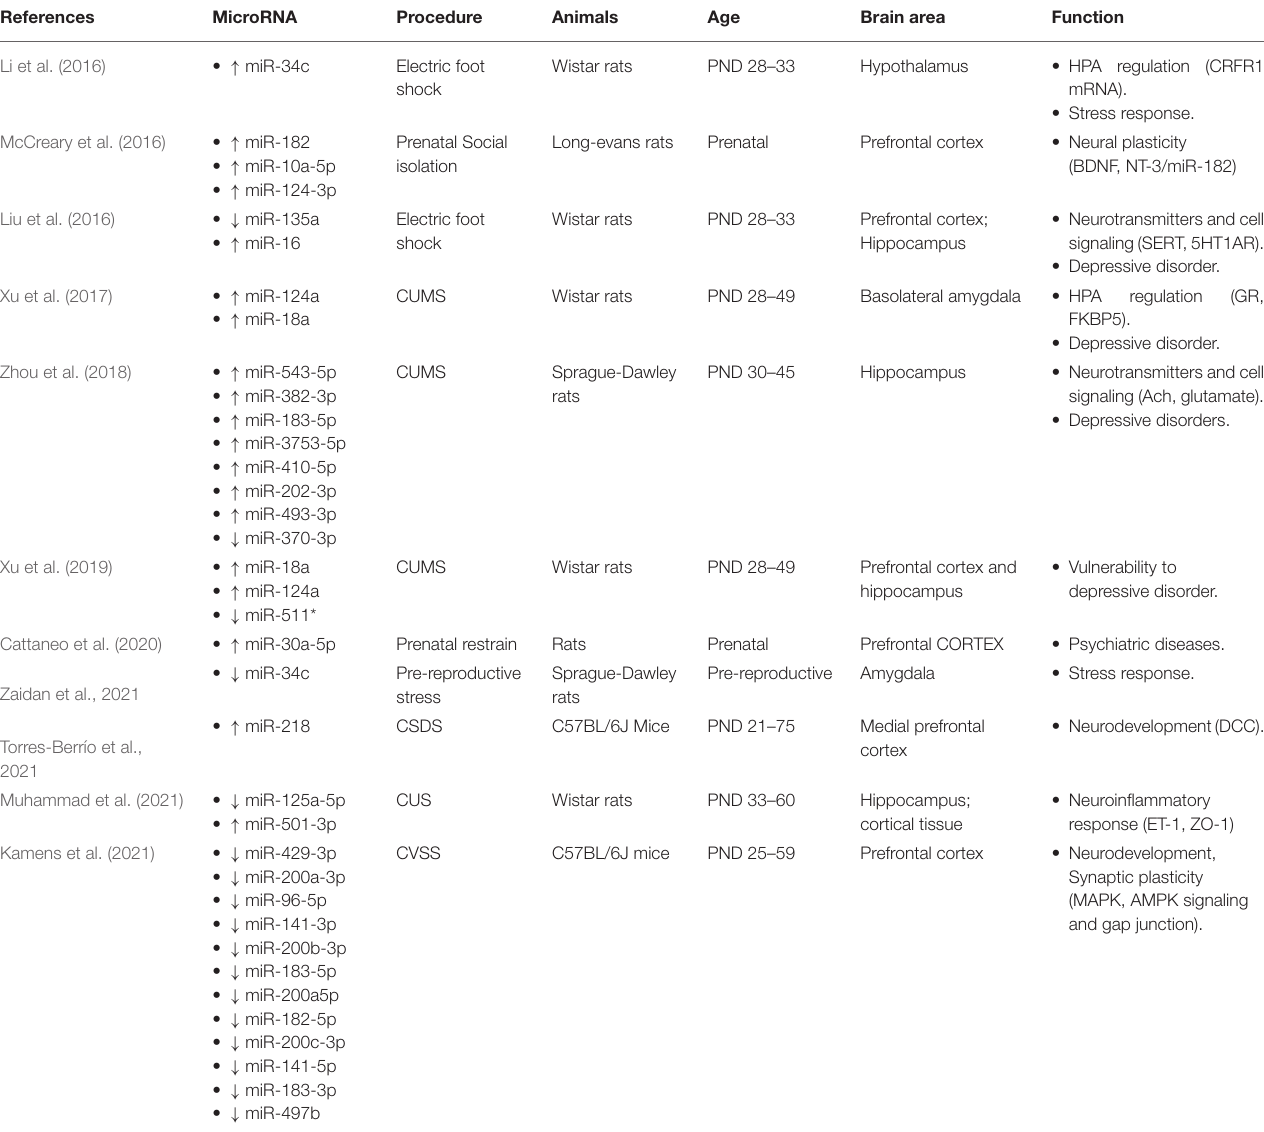
TABLE 3 | Effect of stress on brain miRNA expression and adolescence.